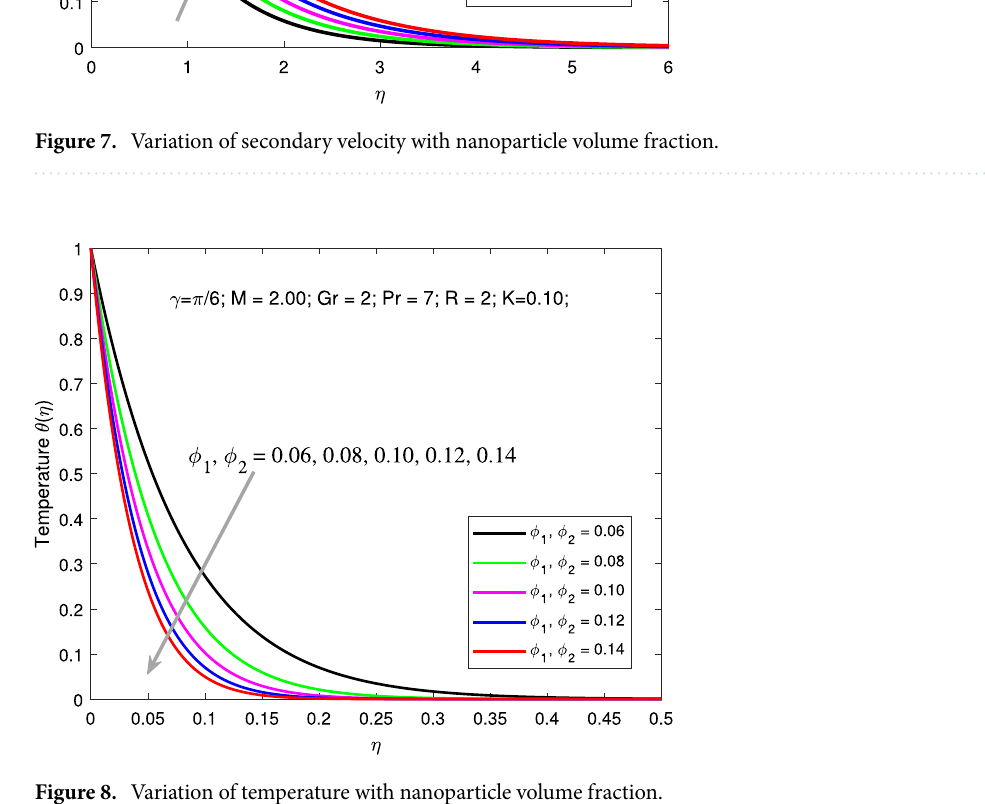
Figure 8. Variation of temperature with nanoparticle volume